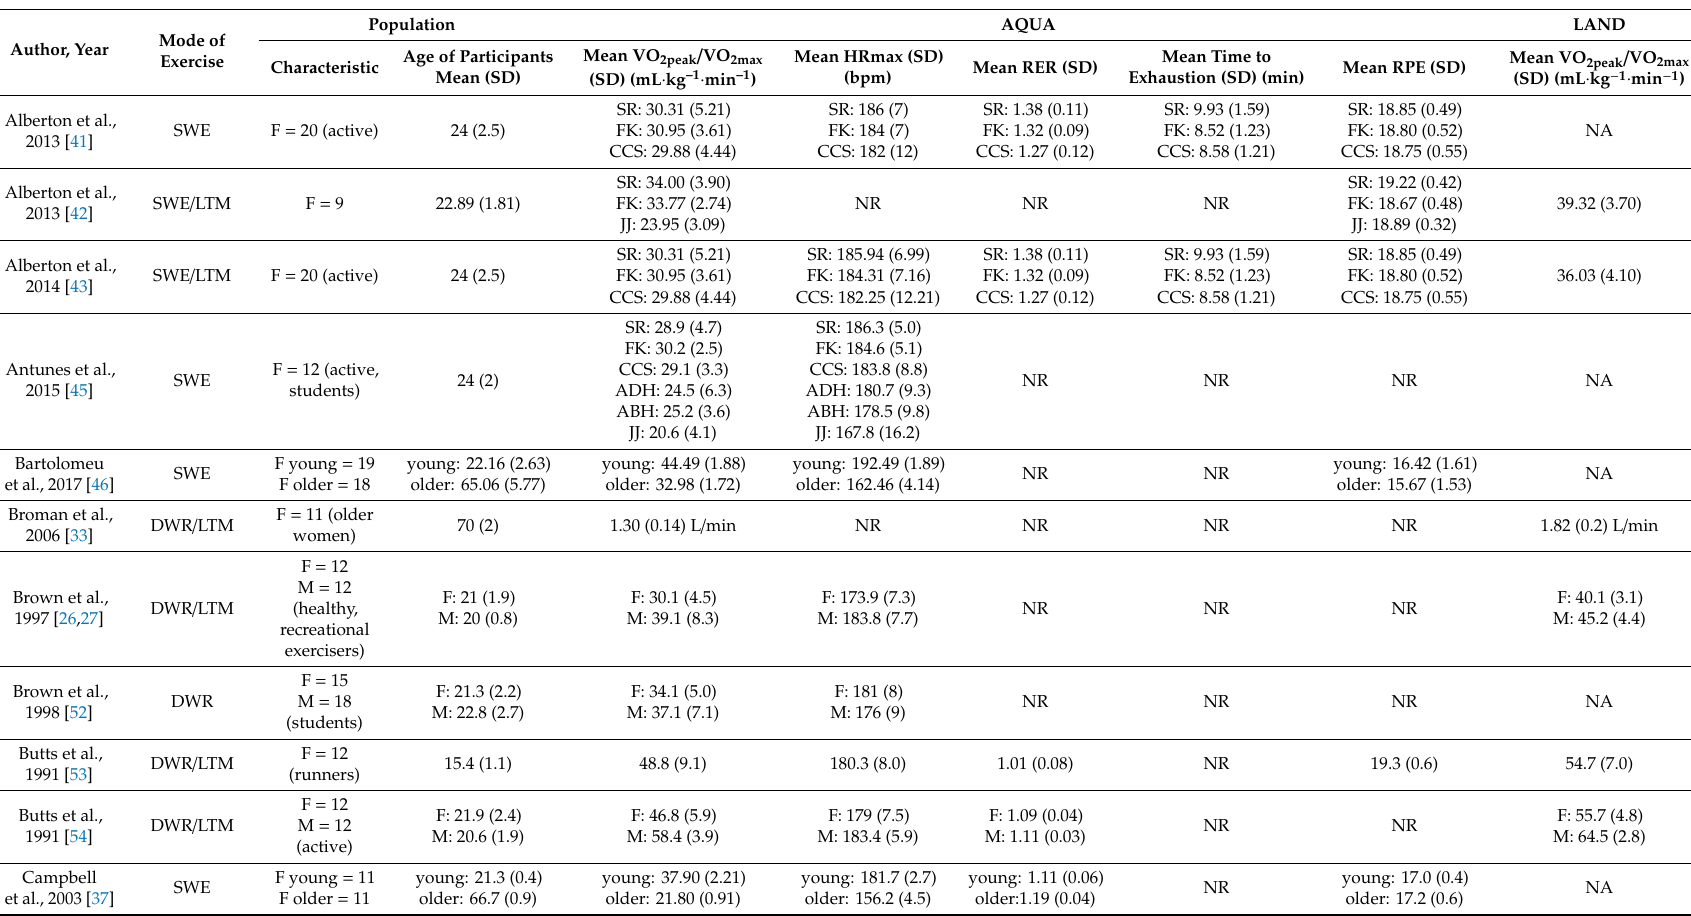
Table 4. Population characteristics and cardiorespiratory fitness